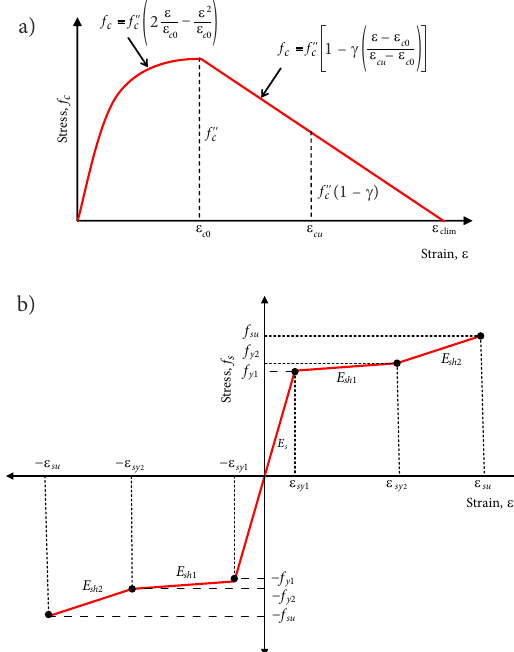
Fig. 2. Stress-strain relationships for (a) concrete in compression and (b)